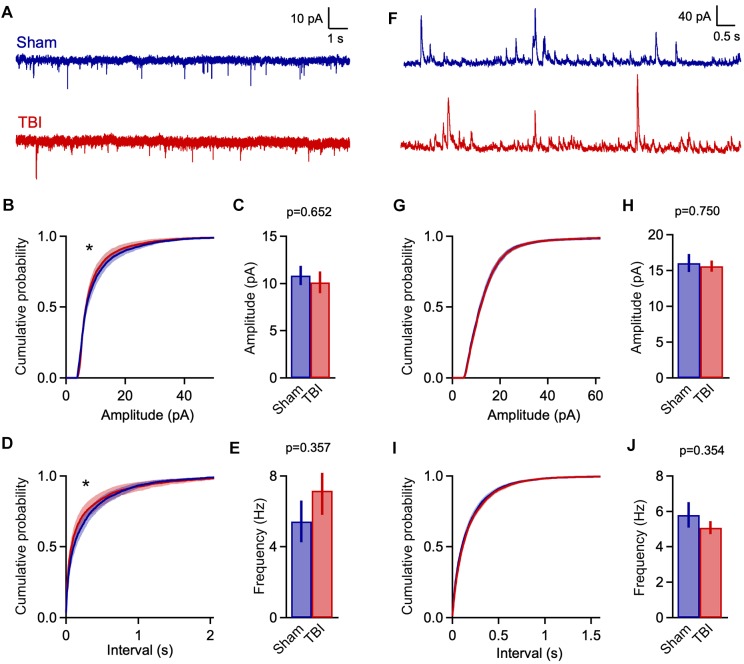
Mild TBI has comparatively minor effects on spontaneous synaptic input 48 h post-injury. (A) Whole cell recordings of excitatory input onto superficial pyramidal cells in piriform cortex. (B,C) Amplitudes of excitatory events showed moderate changes after TBI. Left, cumulative histograms (p = 0.009; k = 0.056; K–S test; n = 1750 sham, 1377 TBI events). Right, mean values [10.8 ± 1.0 vs. 10.1 ± 1.2 pA for sham and TBI; p = 0.652, t(29) = –0.456; 2-sample t-test; n = 9 mice, 14 cells for sham; 11 mice, 17 cells for TBI]. (D,E) Interevent interval and mean frequency for excitatory events. The sEPSC interval distribution shifted slightly toward smaller values after TBI (p = 0.0003; k = 0.074; K–S test; n = 1750 sham, 1377 TBI events) but mean values were not significantly changed [5.4 ± 1.2 vs. 7.2 ± 1.4 Hz for sham and TBI; p = 0.898, 2-sample t-test; t(29) = 0.129; n = 9 mice, 14 cells for sham; 11 mice, 17 cells for TBI]. (F) Spontaneous inhibitory inputs onto the same superficial pyramidal cell recorded at excitatory reversal potential. (G,H) Cumulative histograms and mean values for sIPSC amplitude, which were unchanged by TBI. (I,J) Cumulative histogram of interevent interval and mean frequency values for inhibitory events, which were also unaffected. [p = 0.026; k = 0.038; K–S test; n = 2744 sham, 3213 TBI events; 5.8 ± 0.7 vs. 5.1 ± 0.4 Hz for sham and TBI; p = 0.754; t(29) = 0.317; 2 sample t-test; n = 9 mice, 14 cells for sham; 11 mice, 17 cells for TBI]. ∗ indicates p < 0.01 in K–S tests.